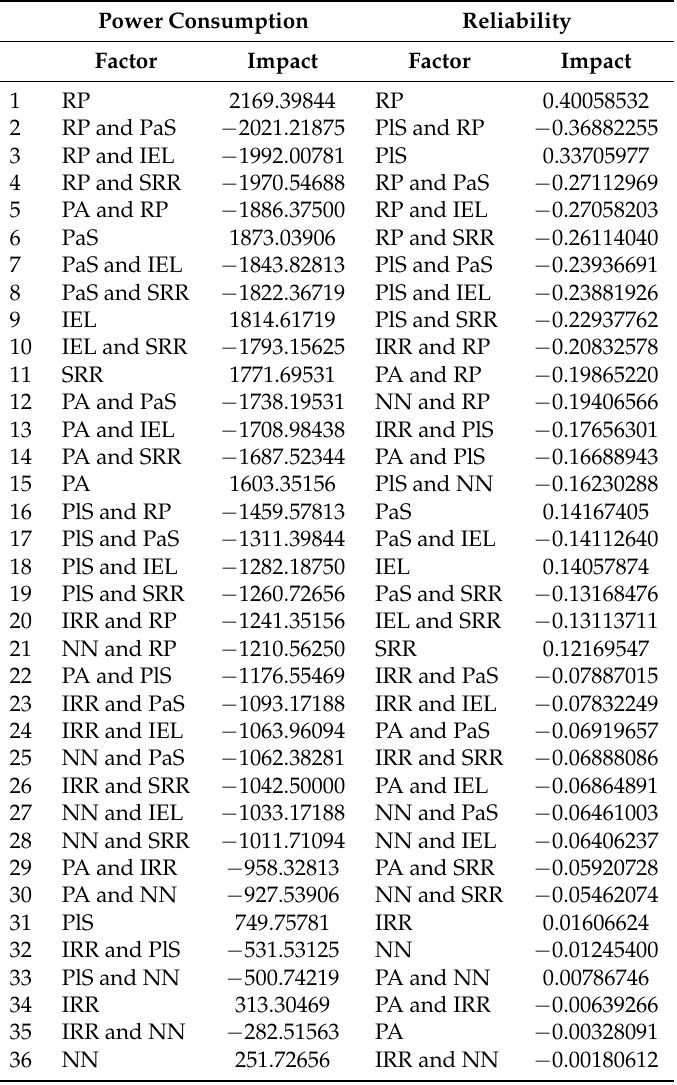
Table 3. Impact of factors on the power consumption and reliability of the